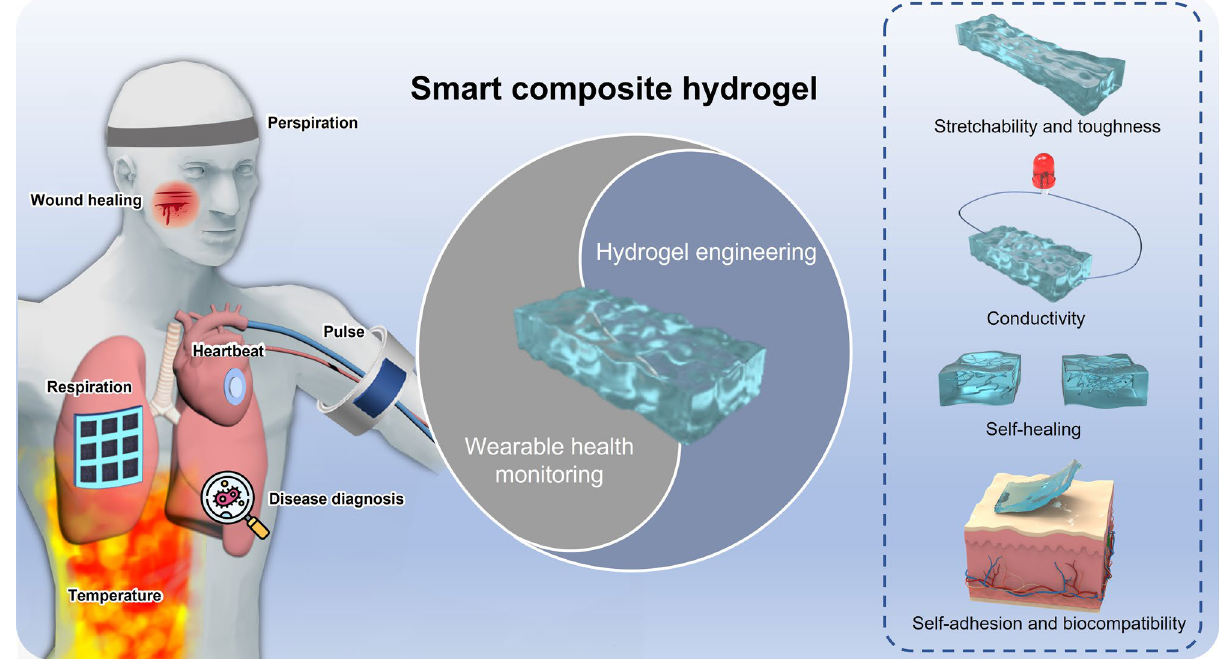
Fig. 1 Engineering smart composite hydrogels for wearable health